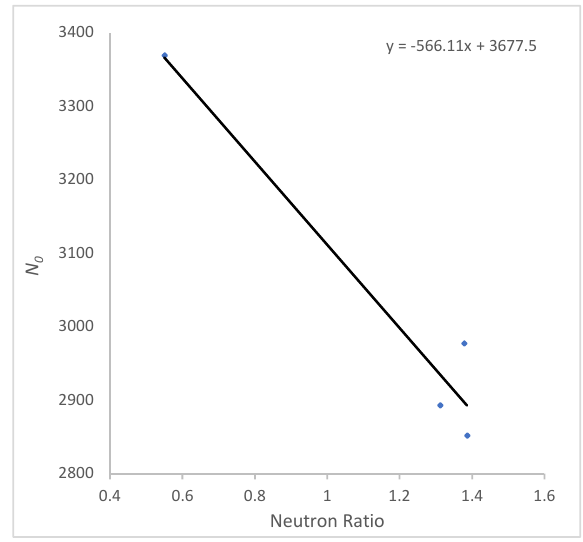
Figure 12. Scatterplot of the ground CRNS neutron ratio (x-axis) against N 0 (y-axis). The trendline equation from Figure 12 (y = − 566.11x + 3677.5) was then used to determine a daily N 0 value using the daily neutron ratio values. The daily N 0 values were then used to determine the CRNS’s soil water content estimates (Figure 13). The time series illustrates the CRNS soil water content estimates under three scenarios: